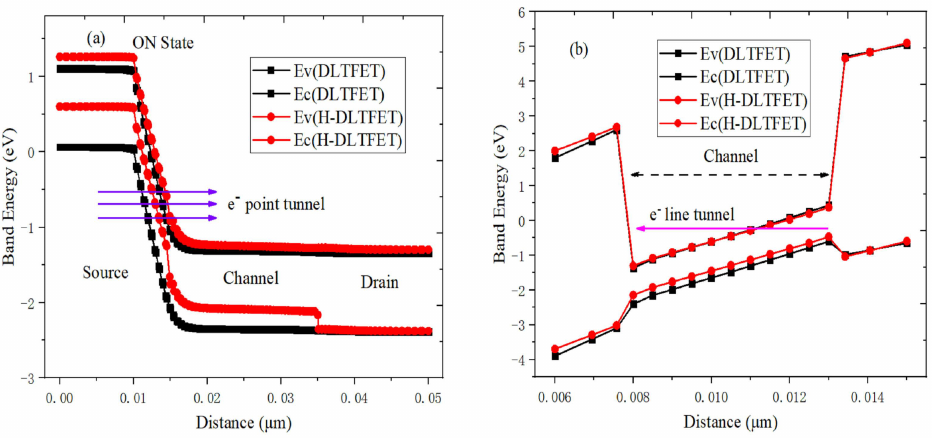
Figure 5. On-state energy band of DLTFET and H-DLTFET ( a ) from source to drain; ( b ) from channel top to channel